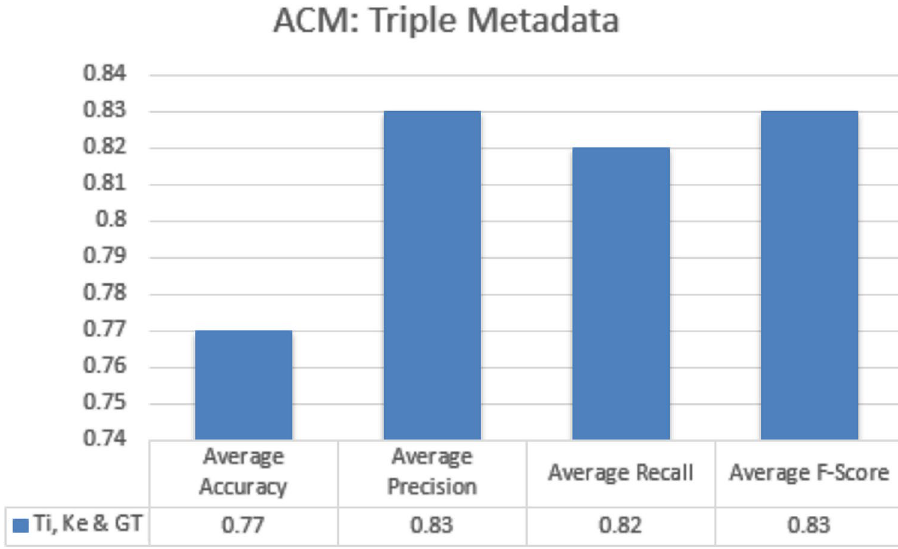
Figure 17. ACM (triple metadata).